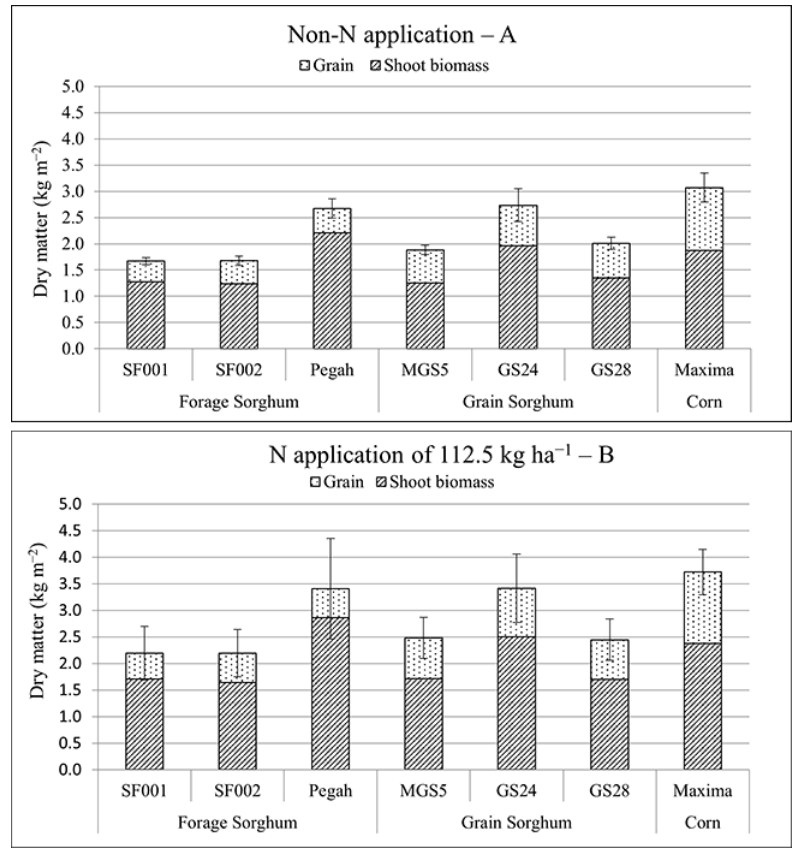
Figure 2 Effects of no-nitrogen treatment ( A ) and nitrogen application ( B ) on shoot biomass and grain yields in corn as well as grain and forage sorghum genotypes. Error bars are related to the amount of total dry matter yield (grain + shoot